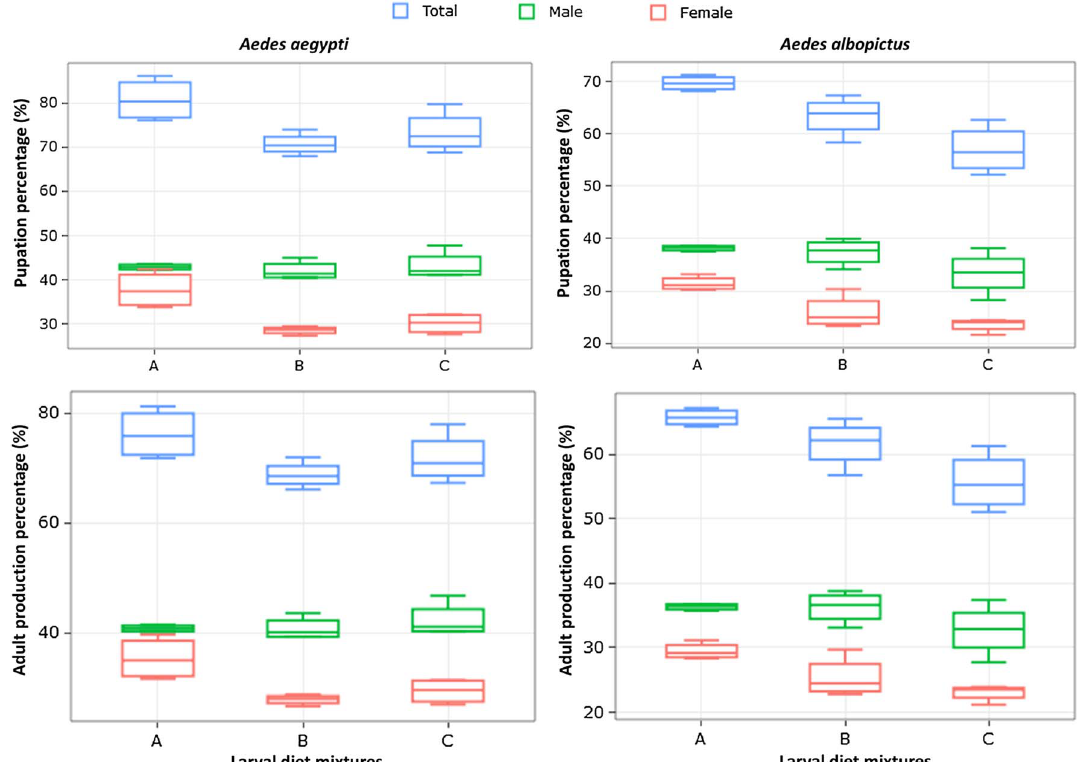
Figure 1. Pupation and adult production percentages in male and female Aedes aegypti and Aedes albopictus. Diet A = 50% TM + 35% BLP + 15% BY, Diet B = 50% TM + 35% BSF + 15% BY, Diet C = 50% TM + 50% BSF.